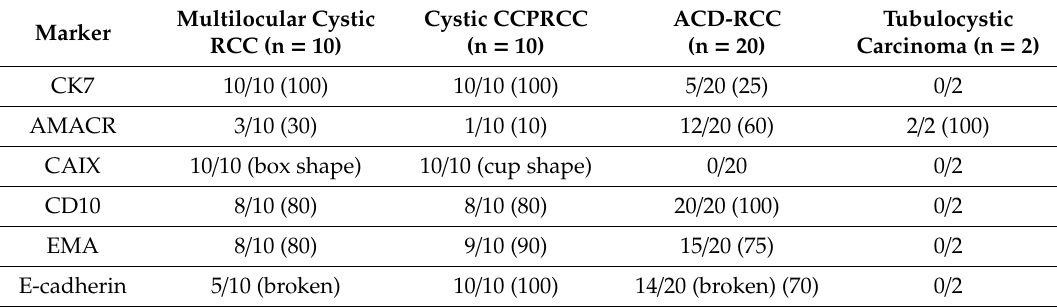
Table 1. Di ff erential immunohistochemistry panels in cystic renal